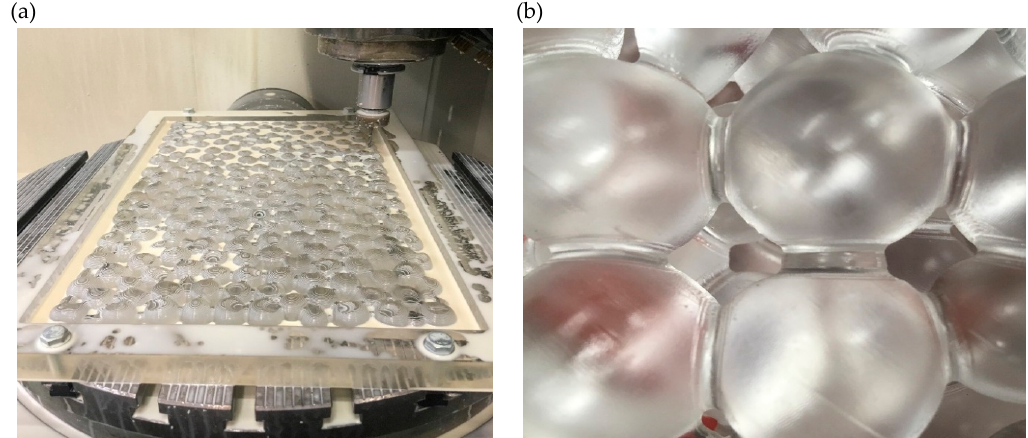
Figure 3. ( a ) A typical plate of the artificial riverbed in the process of being machined using a 4 mm flat, long series bit including the surrounding frame required for clamping the plate to the CNC machine bed; ( b ) A close-up, in plan, of the artificial gravel particles highlighting the fillet detail between adjoining particles and the voids that are typically formed when the layers are stacked.